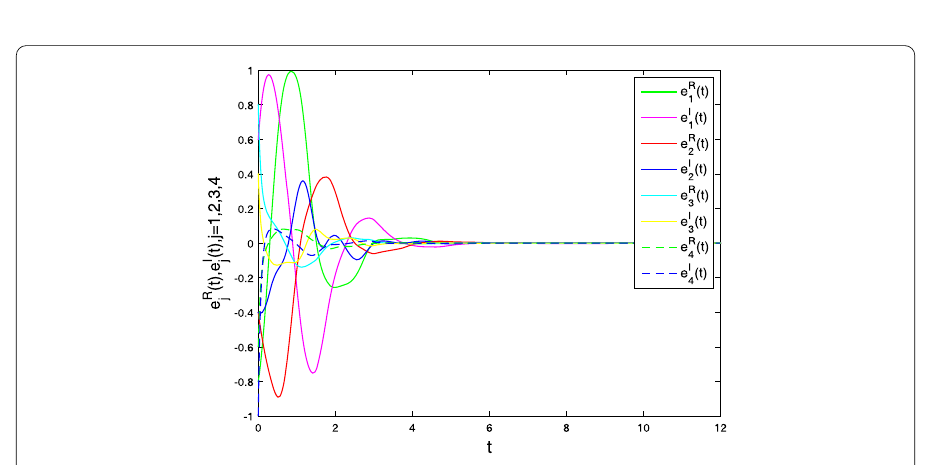
( t ) and e I ( t ) under the partial adaptive controller j j